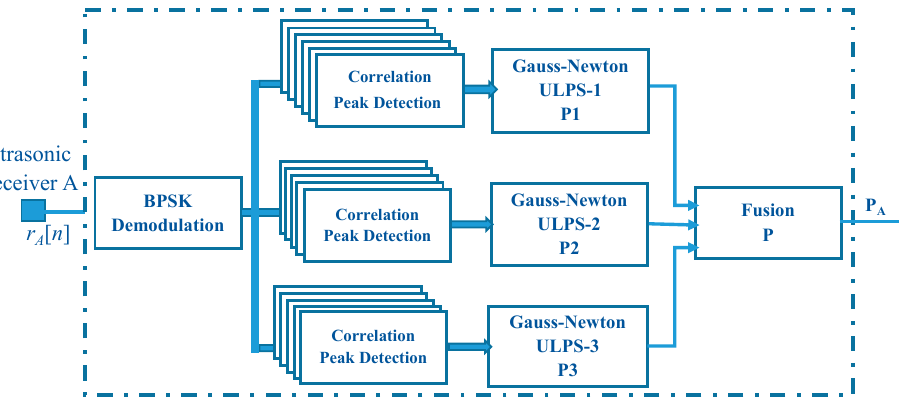
Figure 6. Block diagram of a loosely coupled fusion of the three positions estimated by the receiver R A .